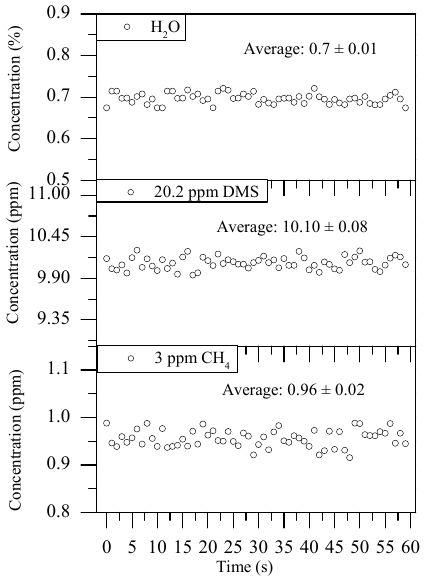
Figure 8. Continuous measurements of DMS, CH 4 , and H 2 O with a duration of 1 min.